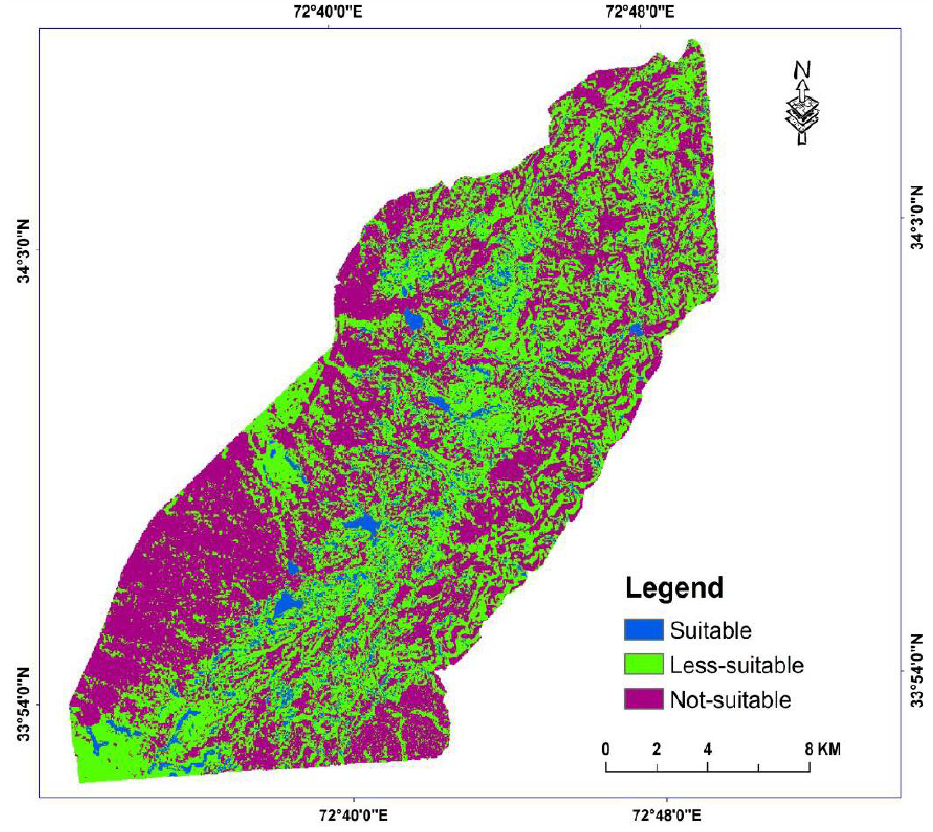
Figure 13. Potential sites for gully plugs.